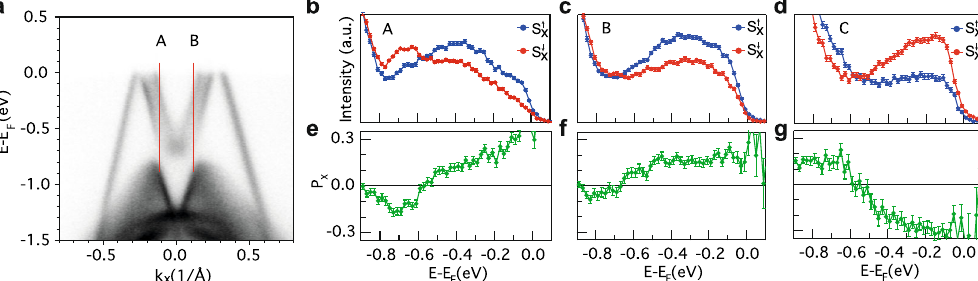
Fig. 5 Experimental bulk spin polarization. a Angle-resolved photoemission spectroscopy (ARPES) intensity map measured along the dashed line of Fig. 3b for a photon energy equal to 48.5 eV. b – d Spin-resolved ARPES spectra for the x spin component measured at wave vectors A = ( − 0.13,0.53)( π / a ), B = (0.13,0.53)( π / a ) (red lines in panel a ), and C = (0.13, − 0.53) ( π / a ). e – g Spin polarization P x measured at wave vectors A , B and C , respectively. The error bars in panels b – g represent the statistical error as described in the “ Methods ” (I and III) ZrTe sectors and on the intermediate (II) Si sector,